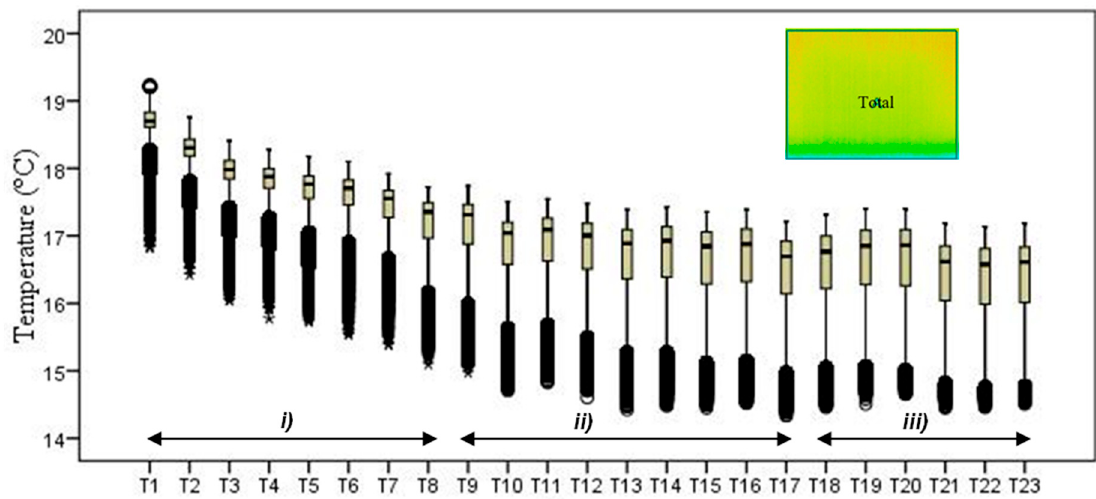
Figure 8. Box-plot representation of the surface temperatures of the entire specimen: ( i ) first hour, when the temperature drop was sharp; ( ii ) between 1 and 9 h, when the temperature kept decreasing, although at a much slower rate; ( iii ) after 9 h, when the temperature remained almost constant until the end of the test.